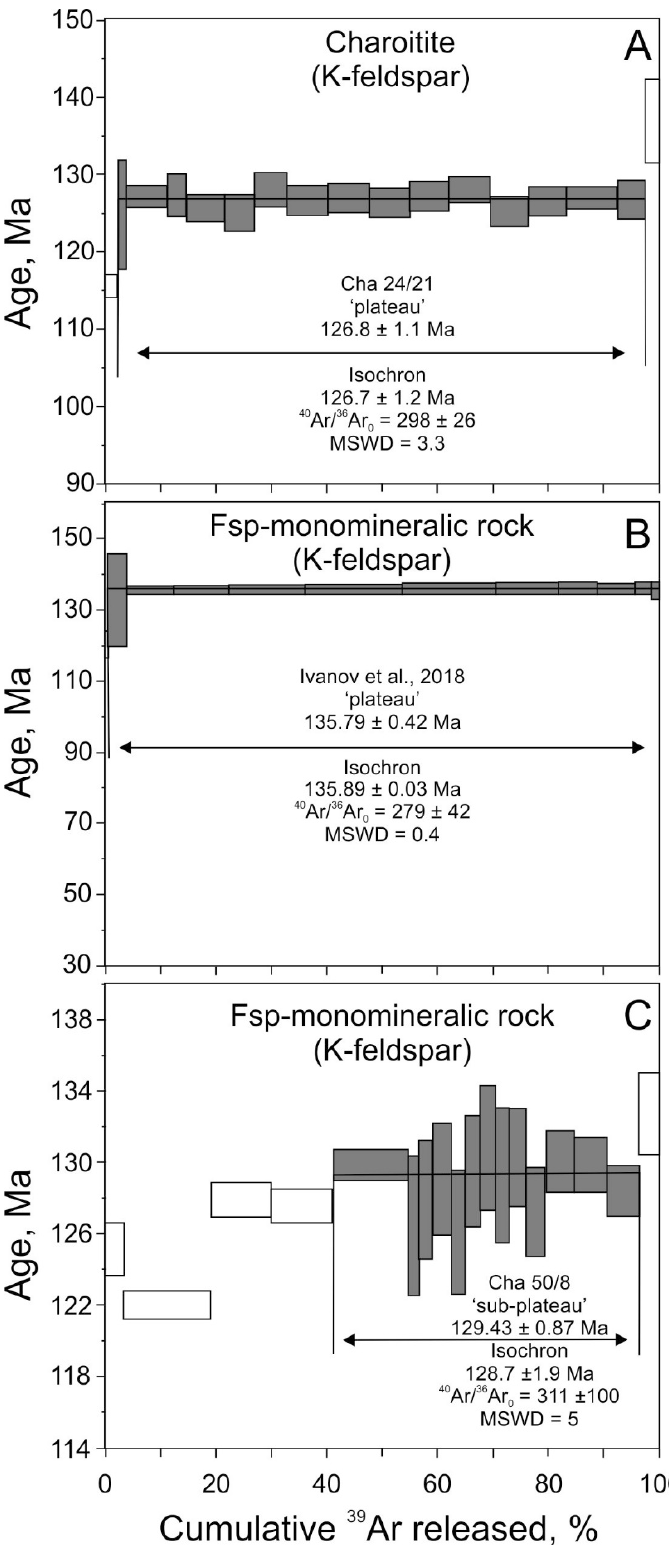
Figure 9. Argon release spectra for K-feldspar of different rocks of the charoitite complex: ( A ) Sample Cha 24/21—K-feldspar from charoitite; ( B ) museum sample of massive microclinite [40]; and ( C ) sample Cha50/8—K-feldspar from a microcline vein. Steps used for calculation of sub-plateau, plateau, and isochron age values are shadowed.